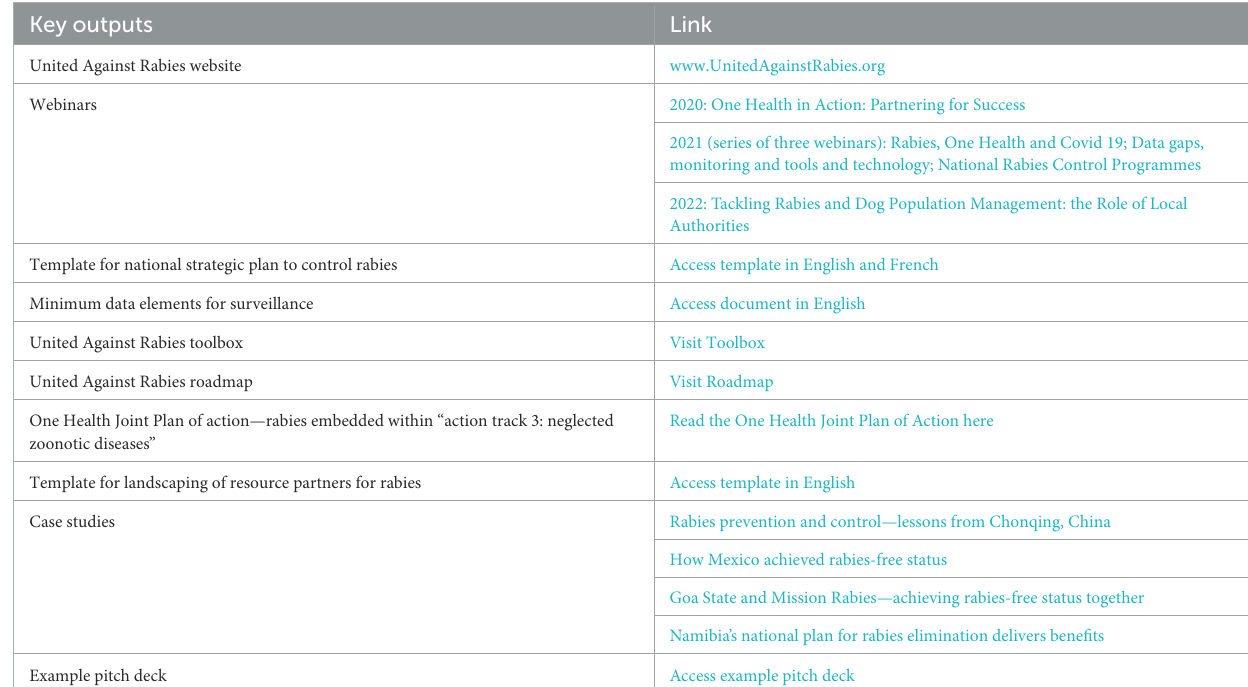
TABLE 1 Links to key outputs of the UAR